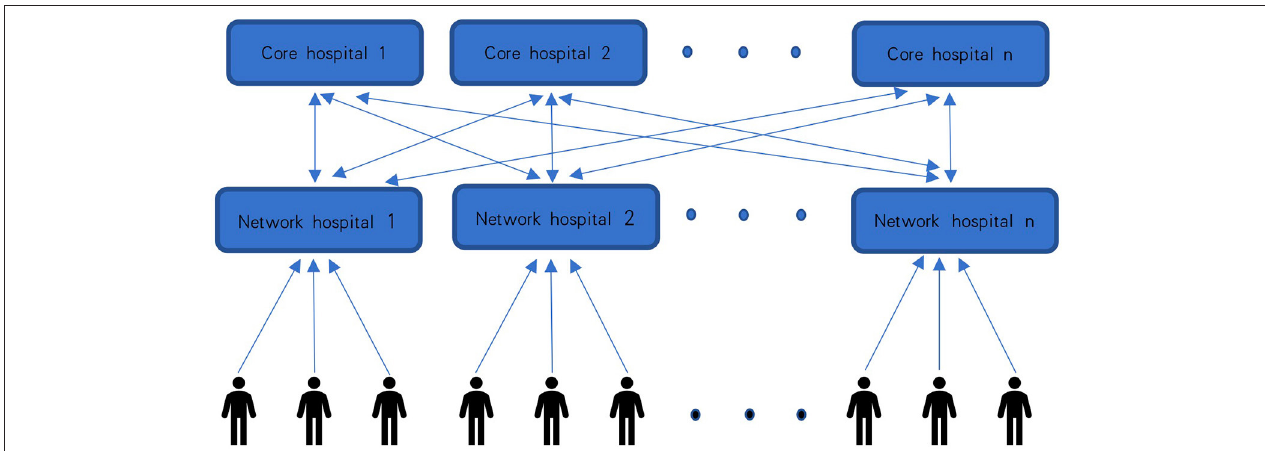
FIGURE 2 | Schematic diagram of regional collaborative cloud follow-up system. Core hospitals (having follow-up clinics or device specialists) establish a regional collaborative cloud follow-up, one-to-one or one-to-many, system with the network hospitals (lack of follow-up clinics or device specialists). A regional collaborative cloud follow-up system covers the whole region and provides follow-up management for the local CIED patients.